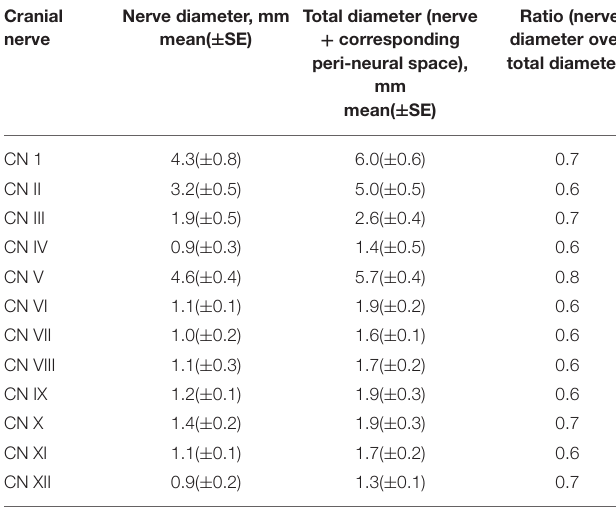
TABLE 1 | Diameter measurements and diameter ratios for all 12 cranial nerves. Cranial Nerve diameter, mm nerve mean( ±